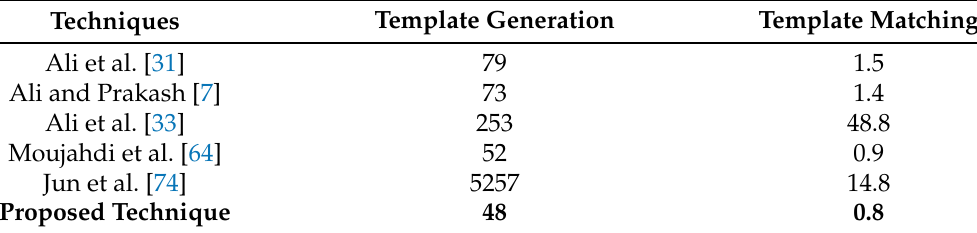
Table 4. Average time taken comparison of various techniques (values